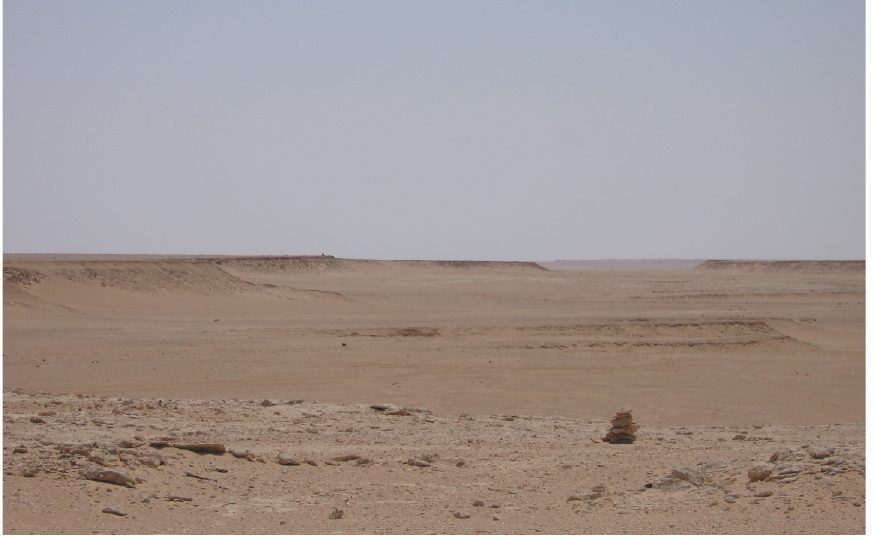
Fig. 14. Recent stone marker ( alam ) on the Northern Marmarica-Plateau (cf. Fig. 4), 17 km west of the modern road between Siwa and Marsa Matruh. (Olaf